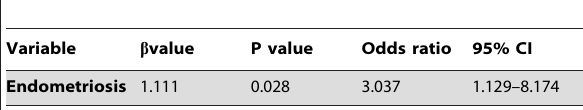
Table 4. Logistic regression analysis for chronic endometritis.